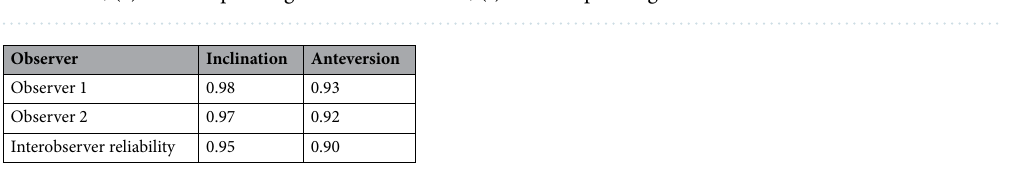
Figure 5. The position relationship between the inferior edge of acetabular cup and the proximal line of the anterior and posterior acetabular notches to determine cup anteversion. ( a ) 1 mm pronating around the PPAPN; ( b ) 3 mm pronating around the PPAPN; ( c ) 5 mm pronating around the PPAPN; ( d ) 1 mm supinating around the PPAPN; ( e ) 3 mm supinating around the PPAPN; ( f ) 5 mm supinating around the PPAPN.